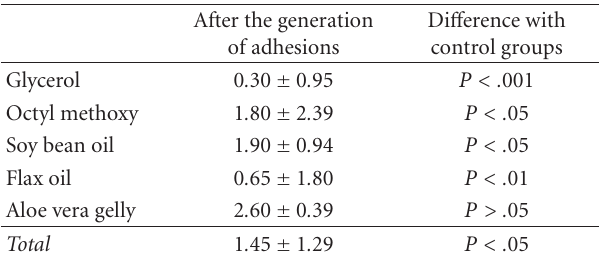
Table 4: Macroscopic adhesion scores of subgroups 4 (score of control group: 2 . 90 ± 0 . 21).